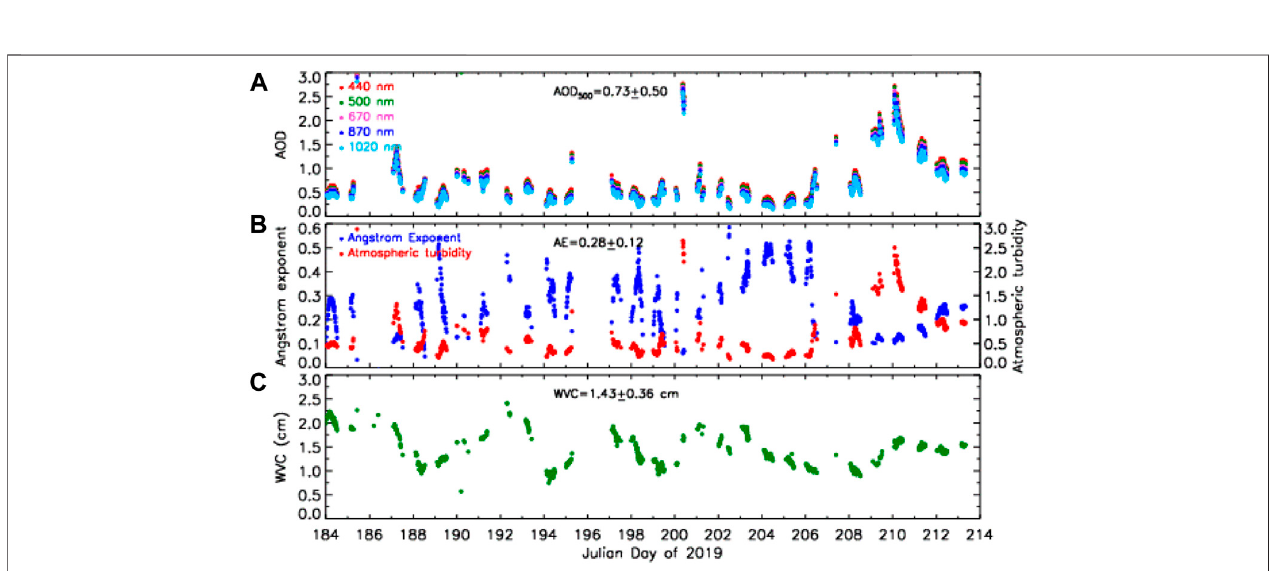
FIGURE3| TimeevolutionsofaerosolopticalpropertiesretrievedbyCimelsun/skyradiometeratTazhongfromJuly2toAugust1,2019. (A) Aerosolopticaldepth. (B) Ångström exponent vs . atmospheric turbidity. (C) Water vapor content in centimeters. The corresponding overall mean values and standard deviation are shown in the fi